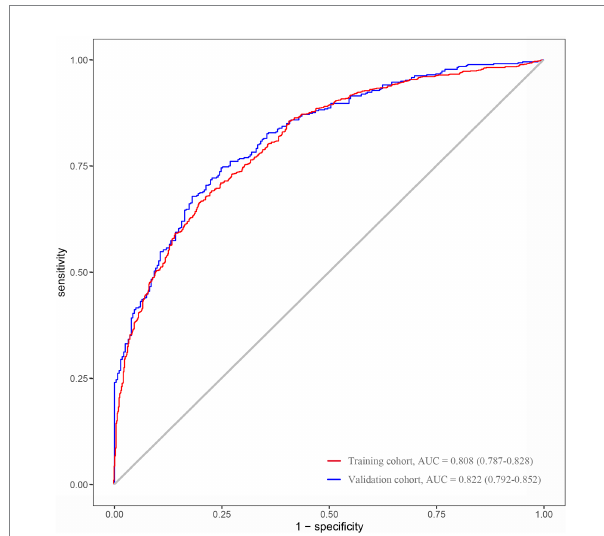
FIGURE 3 AUCs of the nomogram used to predict the presence of poor sleep quality in the training and validation cohorts (ROC, receiver operating characteristic; AUC, the area under the ROC curve).